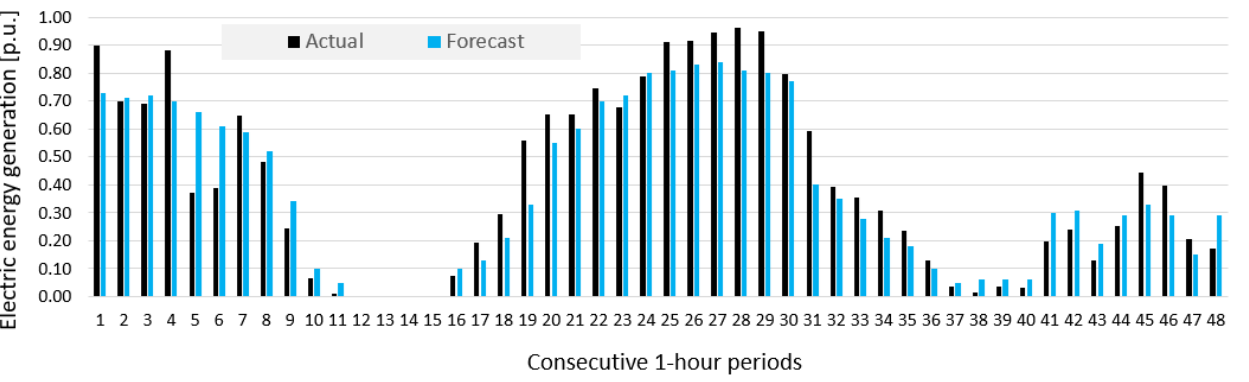
Figure 18. Two forecasts of electric energy generation for Wind Farm A made by INT_OUT_EXT [GBT, RF, PHYS(v1&v2) → KNNR, MLP, LSTM] method with additional expert correction for two consecutive days of the winter month (January).